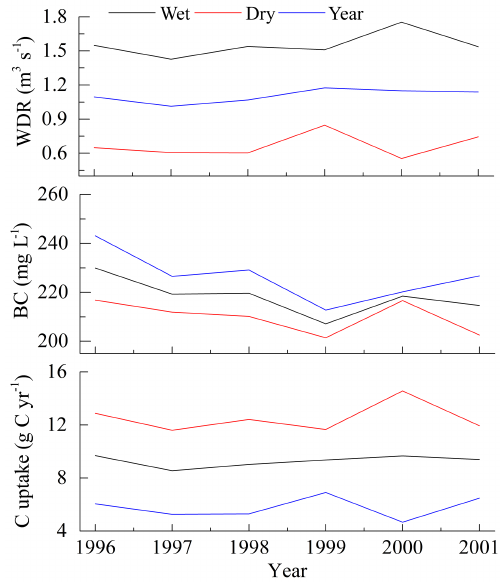
Figure 4. Variation in run-off, ion concentration, and carbon sink for the MSK station (1996–2001).